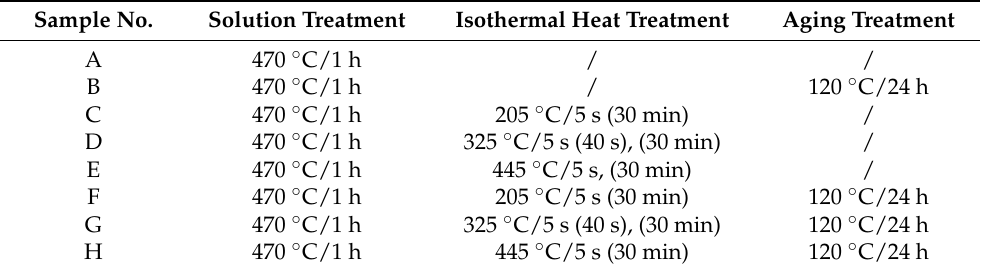
Table 2. Heat treatment parameters of the samples with different methods. Sample